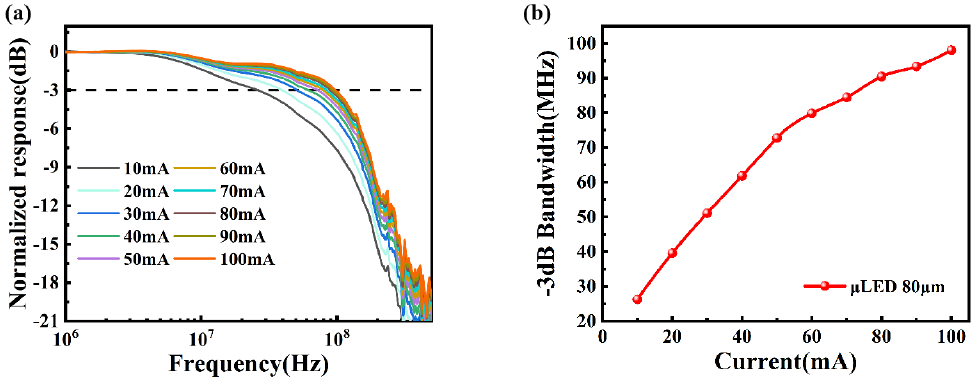
Figure 6. ( a ) Normalized frequency responses of the InGaN-based micro-LED and ( b ) the extracted − 3 dB modulation bandwidth characteristics of the InGaN-based micro-LED at different bias currents from 10mA to 100